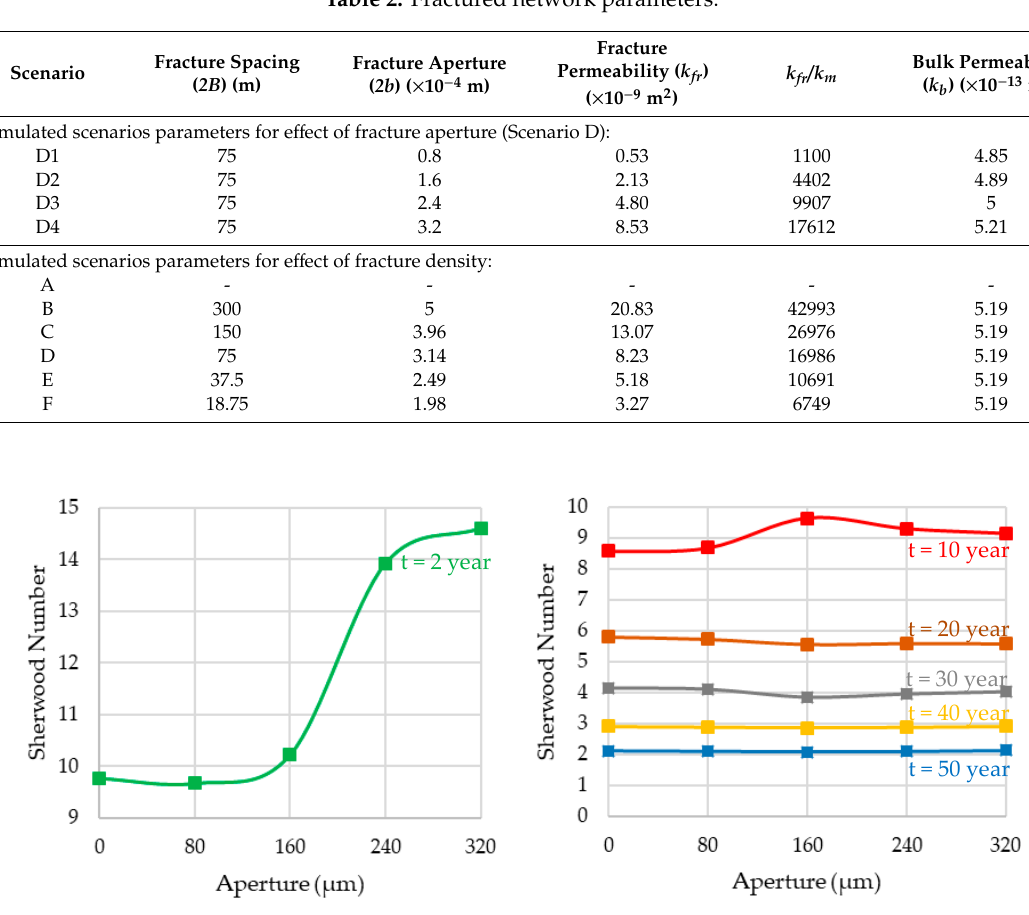
Figure 11. Variation of the average Sherwood number versus the fracture aperture (scenario D).